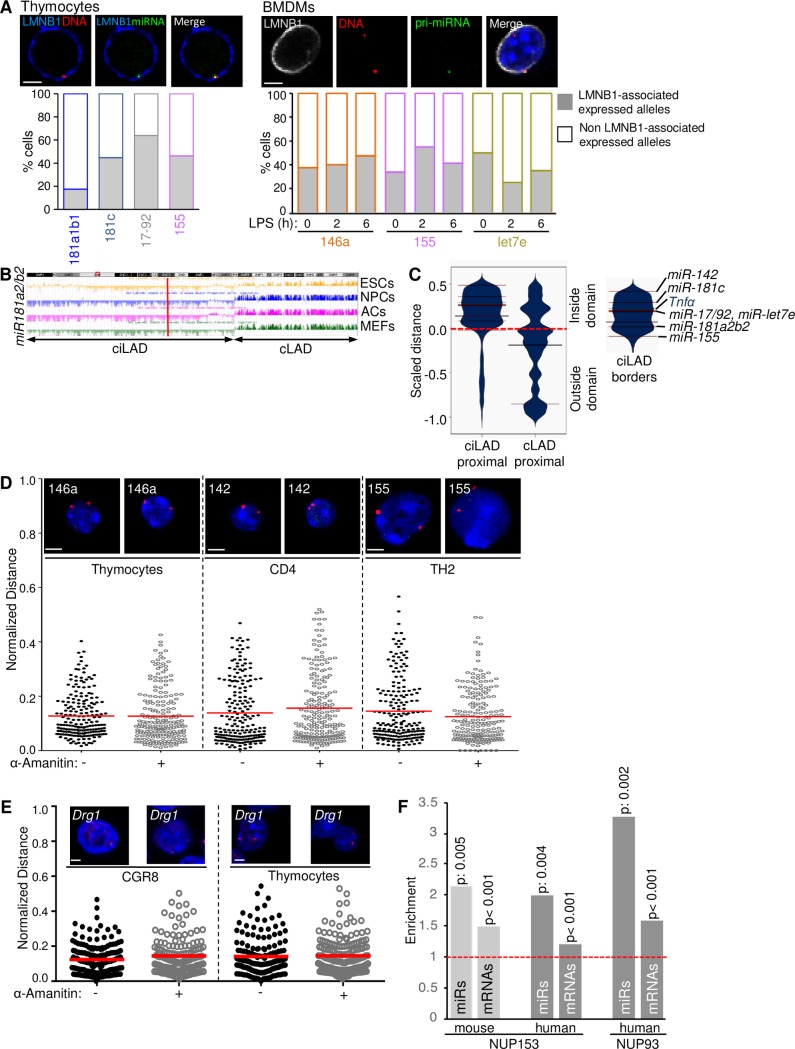
The perinuclear localization of microRNA gene loci is independent of their transcriptional activity.(A) Single z-stack images displaying the colocalization of expressed (green) microRNA gene alleles (red) with Lamin-B1 in thymocytes and BMDMs (before and upon LPS stimulation for the indicated time points). Bar graphs represent the percentage of expressed alleles colocalized with the nuclear lamina. Number of nuclei assessed: thymocytes n = 705, BMDMs/-LPS n = 492, BMDMs/+2h LPS n = 1128, BMDMs/+6h LPS n = 1028. Scale bar 2μm. B) 2Mbp region of mouse chromosome 2 with miR-181a2b2 gene. ciLAD/cLAD analysis in four distinct cell types, embryonic stem cells (ESCs), neural progenitors (NPCs), astrocytes (ACs) and mouse embryonic fibroblasts (MEFs). (C) Beanplots portraying the scaled distance distribution of microRNA genomic sequences to their most proximal ciLAD/cLAD regions. Red lines represent the microRNA genes under study, whereas the green line corresponds to TNFα locus. Small but interesting tendencies for the localization of microRNA sequences either towards the centers of ciLADs, or at the cLAD/ciLAD boundaries are observed and recapitulated by the Wilcoxon rank-sum test (p-value < = 10e-90). (D) Single z-stack images of 3D DNA-FISH nuclei and scatter plot indicating the ND distribution of microRNA gene alleles before and upon transcriptional inhibition with α-amanitin treatment in thymocytes, CD4+ and TH2 cells. Number of nuclei assessed: thymocytes n = 400, CD4+ n = 400, TH2 n = 398. Scale bar 2μm. (E) Scatter plot indicating the ND distribution of the cLAD localized Drg1 gene before and after α-amanitin treatment of CGR8 mouse embryonic stem cells and thymocytes. Number of nuclei assessed: CGR8/(-)α-amanitin n = 170, CGR8/(+)α-amanitin n = 144, thymocytes/(-)α-amanitin n = 158, thymocytes/(+)α-amanitin n = 164. (F) Assessment of overlap tendencies between a) microRNA and b) protein coding mRNA gene loci with peaks corresponding to human and mouse nucleoporins. Enrichment of colocalization was calculated as observed over expected ratios of overlaps between the compared genomic regions. P-values were calculated on the basis of 1000 random permutations of the peaks’ regions. Values <0.001 indicate not one out of 1000 permutations had a value as high as the observed.